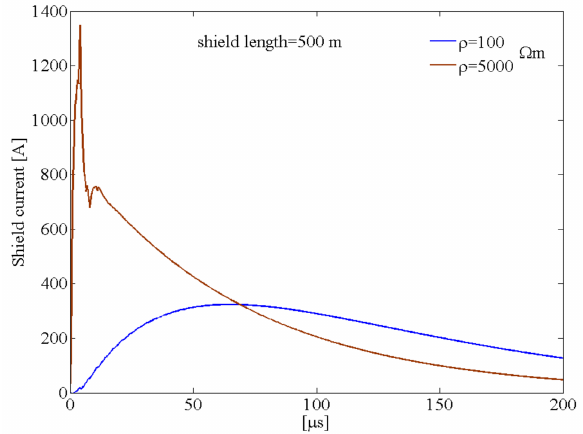
Figure 5. Current time profiles of the equivalent 3 × 6 mm 2 metal shields. The distance between the HV/MV station and the MV/LV substation is set equal to 500